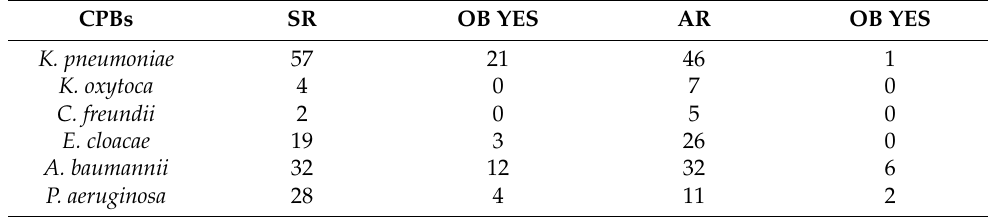
Table 5. Comparison between identified SRs and those involved in a nosocomial outbreak of CPB.